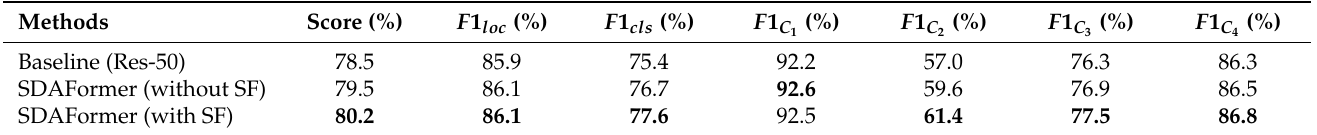
: F 1 score of no damage; F 1 C 1